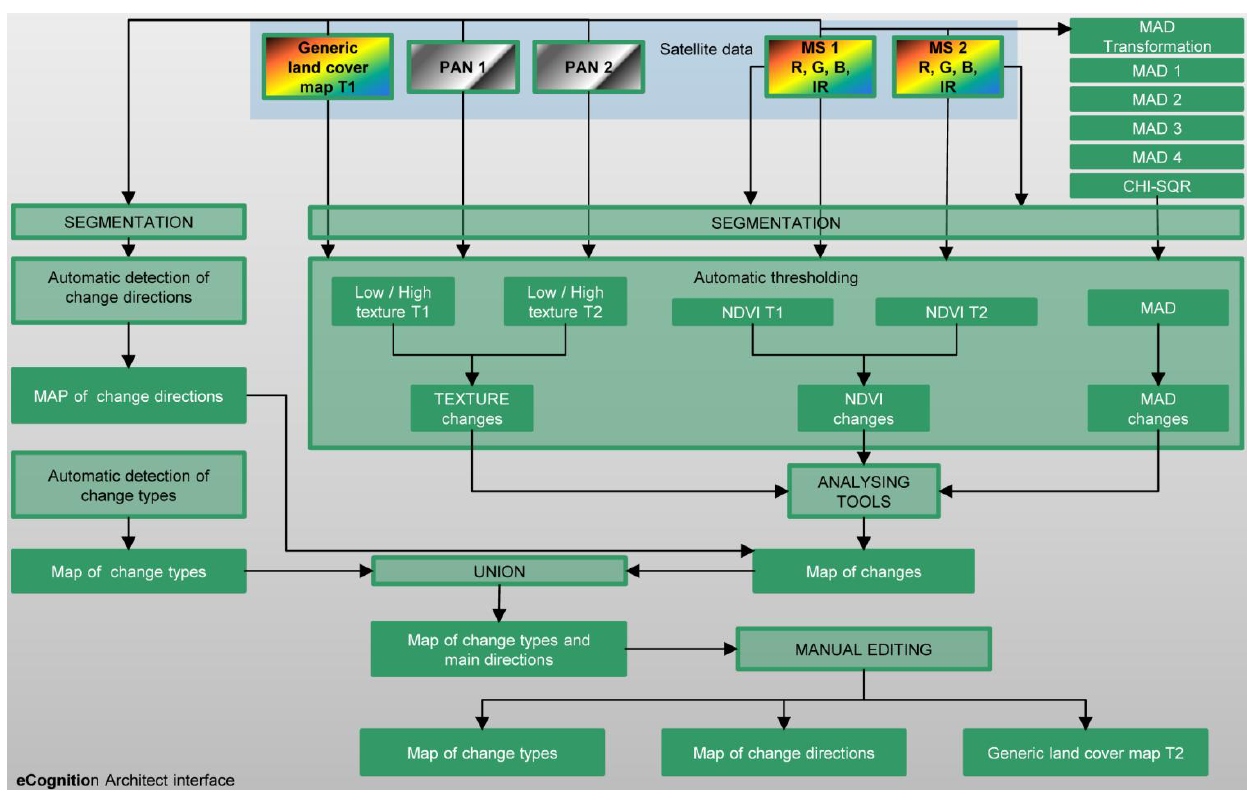
Figure 5. Change detection and classification